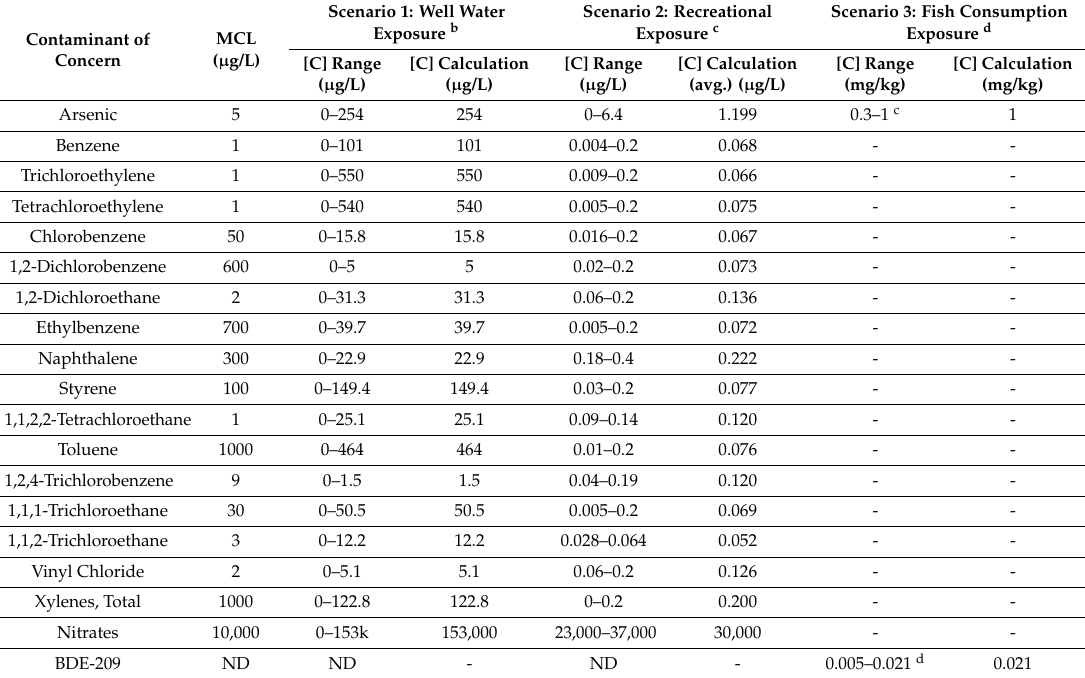
Table 2. Contaminant concentrations across all three scenarios a